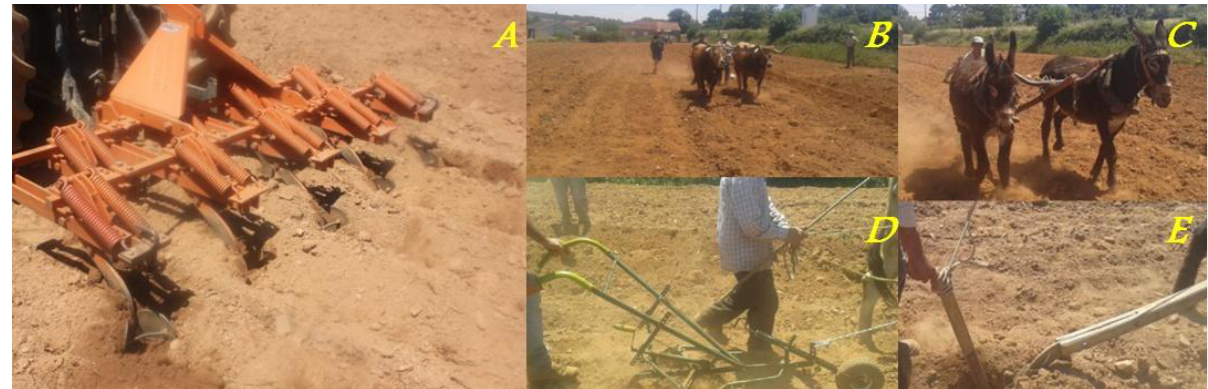
Figure 3: Traction means and implements used in the field experiment: the 9 tine cultivator pulled by a tractor (A), the Mirandesa cows (B) and Mirandês donkeys (C), the 5 tine cultivator (D), and the roman plough